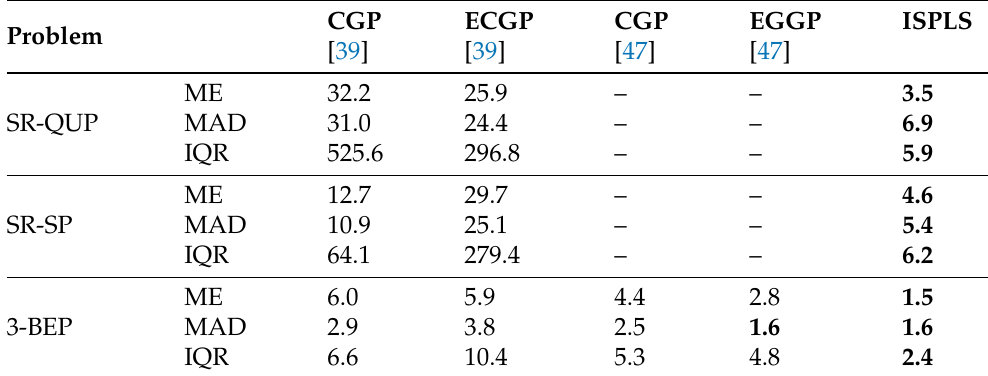
Table 5. Comparison of CGP, ECGP, EGGP and ISPLS algorithms, in terms of ME, MAD, and IQR. All values are expressed in terms of thousands.